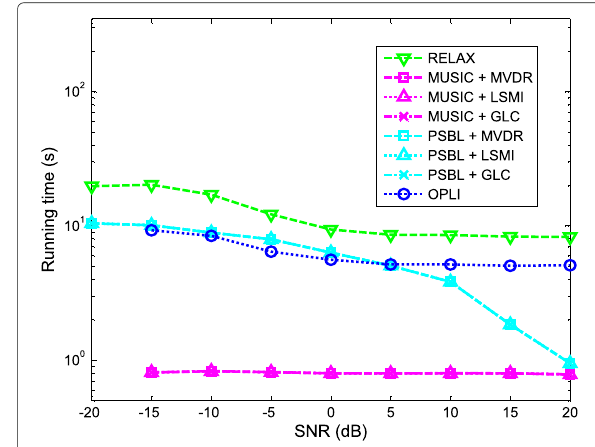
Fig. 12 Running time versus angular